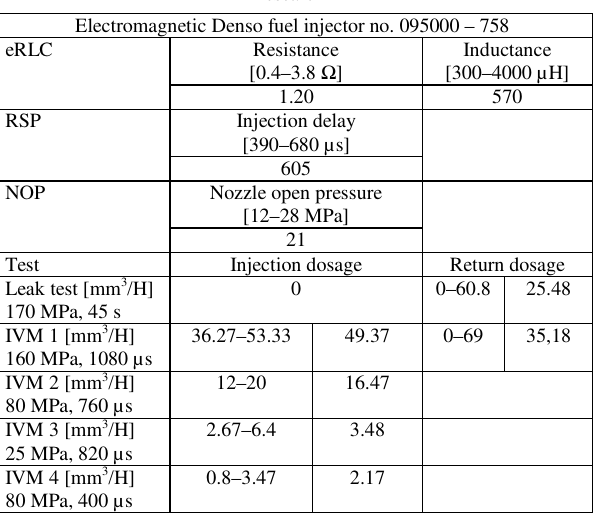
Table 5. Test results of faultless electromagnetic Denso fuel injector research